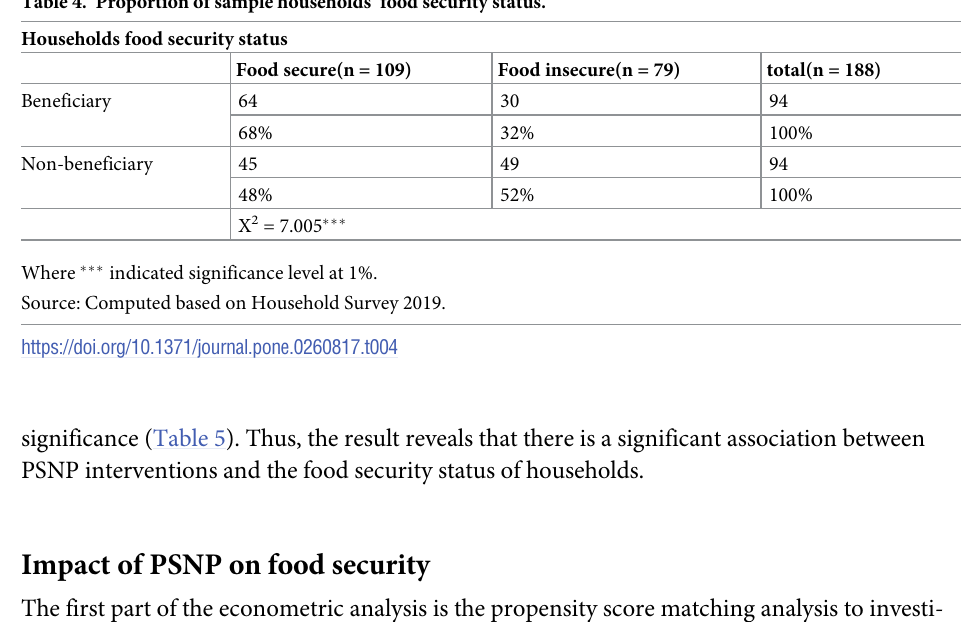
Table 4. Proportion of sample households’ food security status.